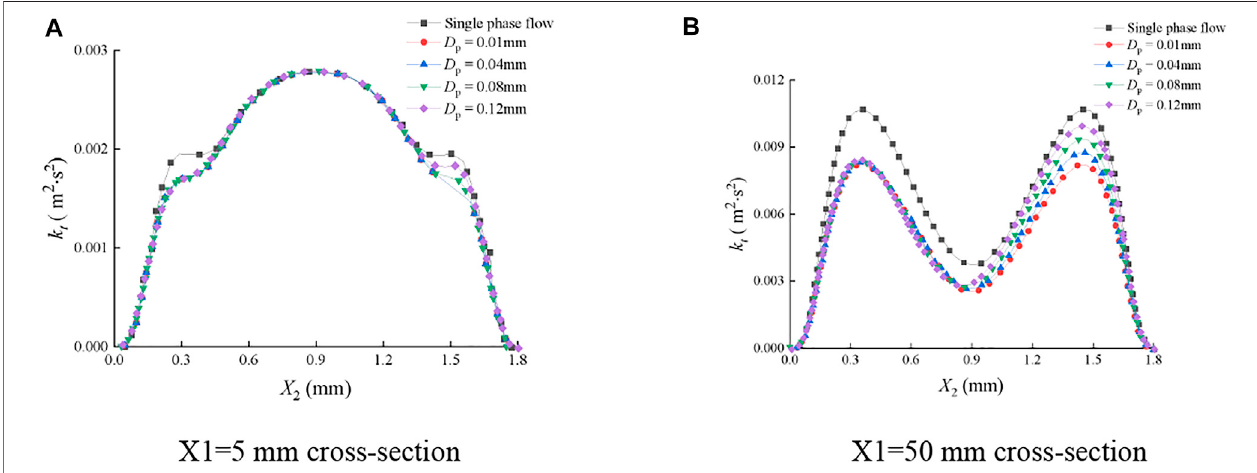
FIGURE 15 | Distribution of turbulent kinetic energy of the continuous-phase fl uid on cross sections of the smooth fracture. (A) X1=5 mm cross section; (B) X1=50 mm cross section.